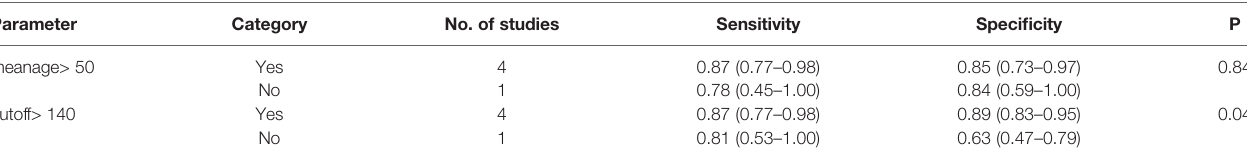
TABLE 5 | meta-regression of HE4 after third chemotherapy.